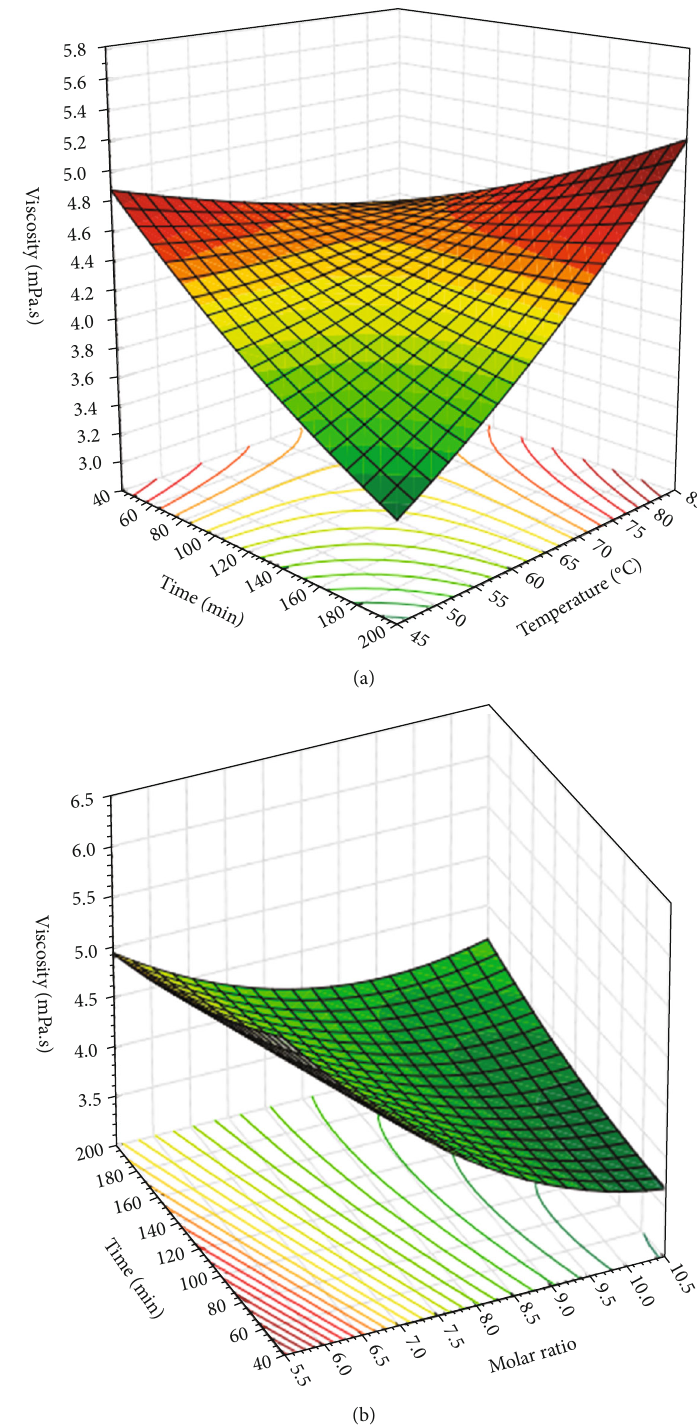
Figure 4: (a) Response surface contour for the e ff ect of interaction between temperature and time on viscosity (KOH concentration: 1wt.%). (b) Response surface contour for the e ff ect of the interaction between time and molar ratio on viscosity (KOH concentration: 1